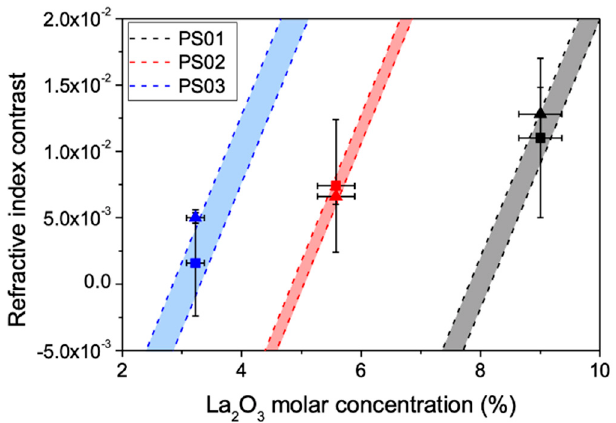
Figure 5. Refractive index contrast as a function of the local La 2 O 3 concentration in the guiding region estimated from local compositional measurements (squares) and near field measurements (triangles). The shadowed regions mark the limits for the polarizability (composition) based estimates considering that are given in Table